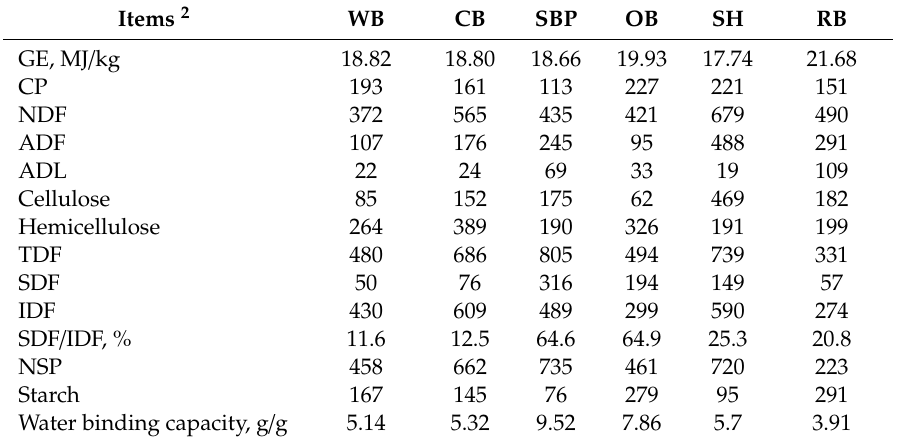
Table 2. The chemical components of di ff erent high-fiber feed ingredients (g / kg, DM basis) 1